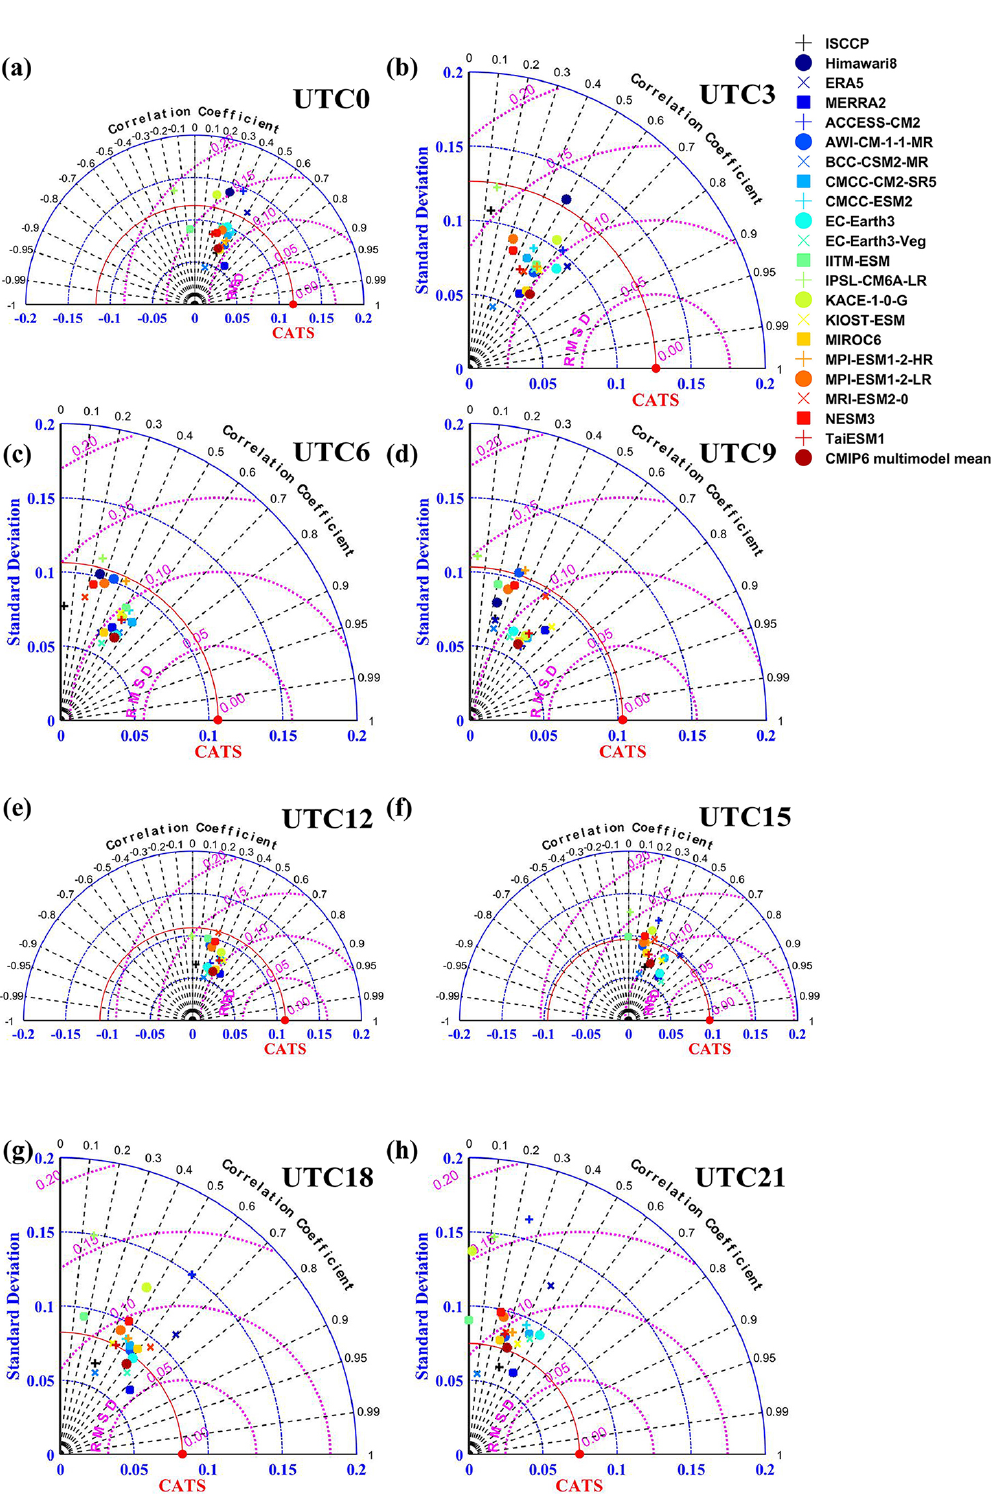
Figure A1. The Taylor diagram describing spatial consistency of total cloud cover between different datasets and CATS every 3h. The distance from the origin of the coordinate axis represents the standard deviation for each dataset in spatial distribution. The distance from the red dot labeled “CATS” represents centered root-mean-square deviation (RMSD, purple circle). The time represented by each image is displayed in the upper-right corner, and the time here is local